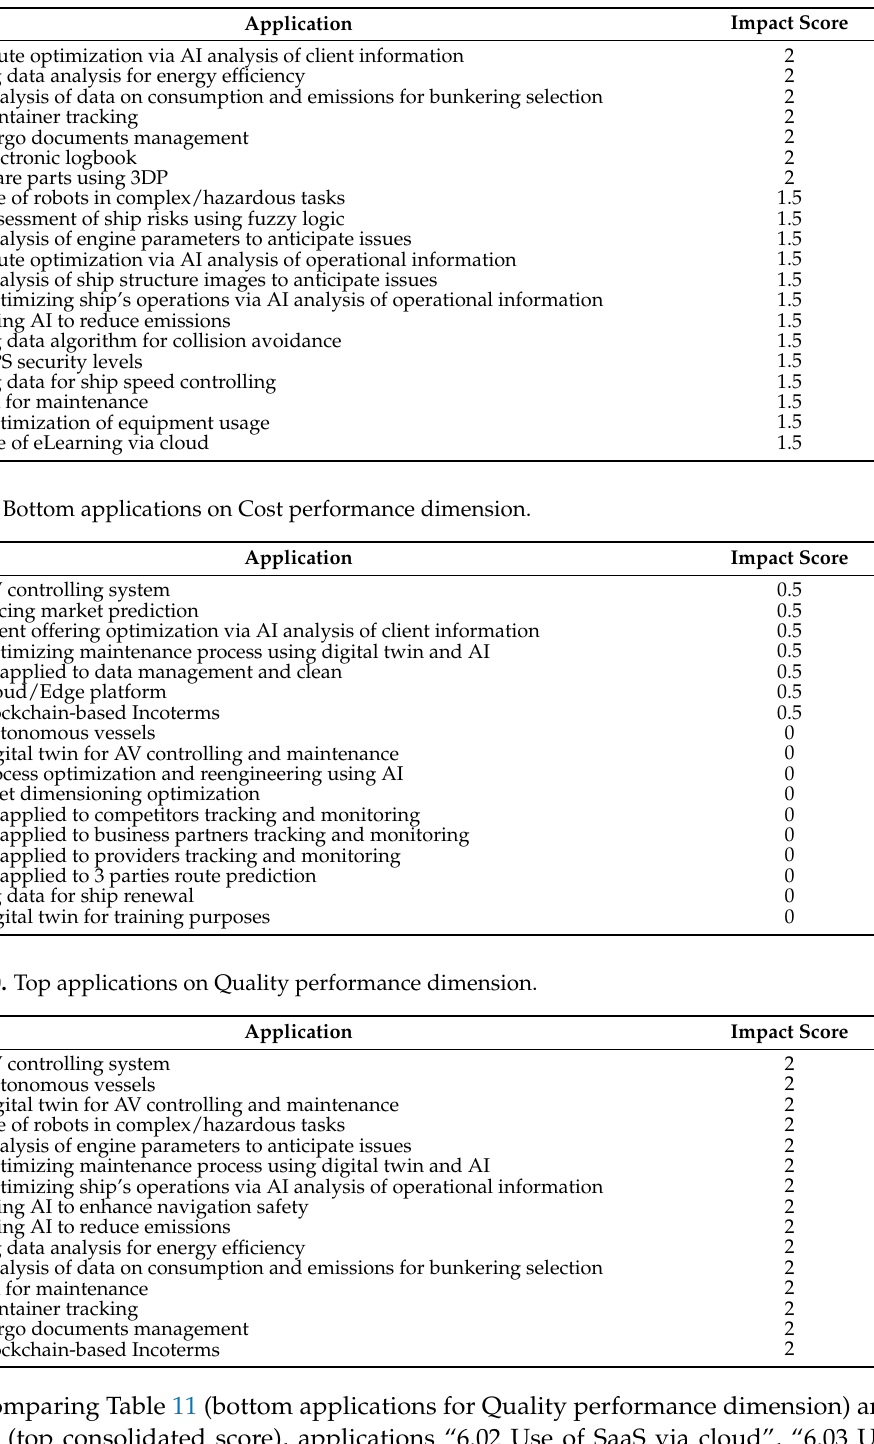
Comparing Table 11 (bottom applications for Quality performance dimension)